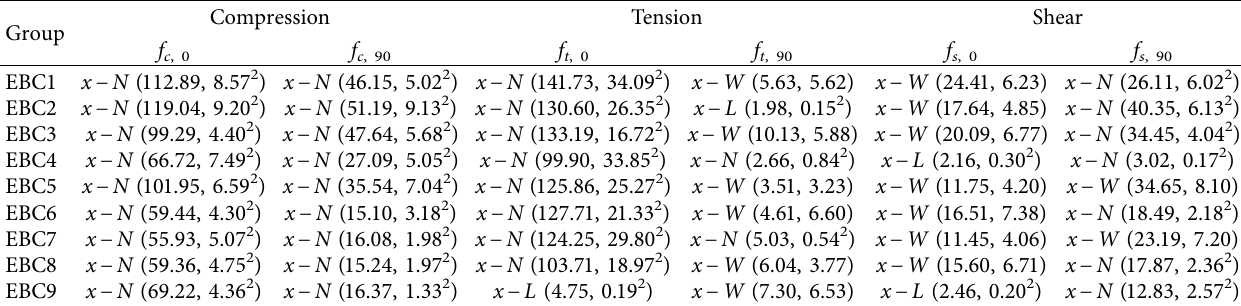
Table 5: The details of the best-fit distribution functions of strengths for EBC.